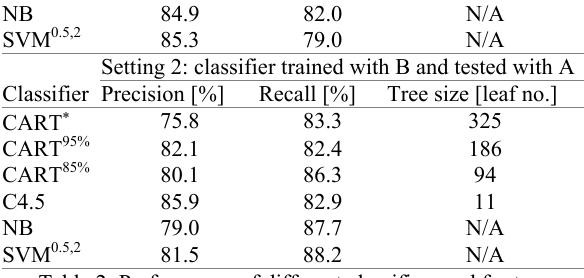
Table 2: Performance of different classifiers and for two